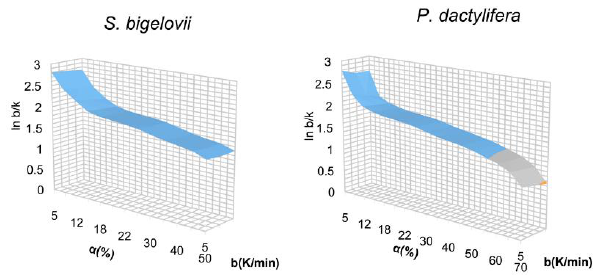
Figure 5. KAS Plot for S. bigelovii , P. dactylifera.